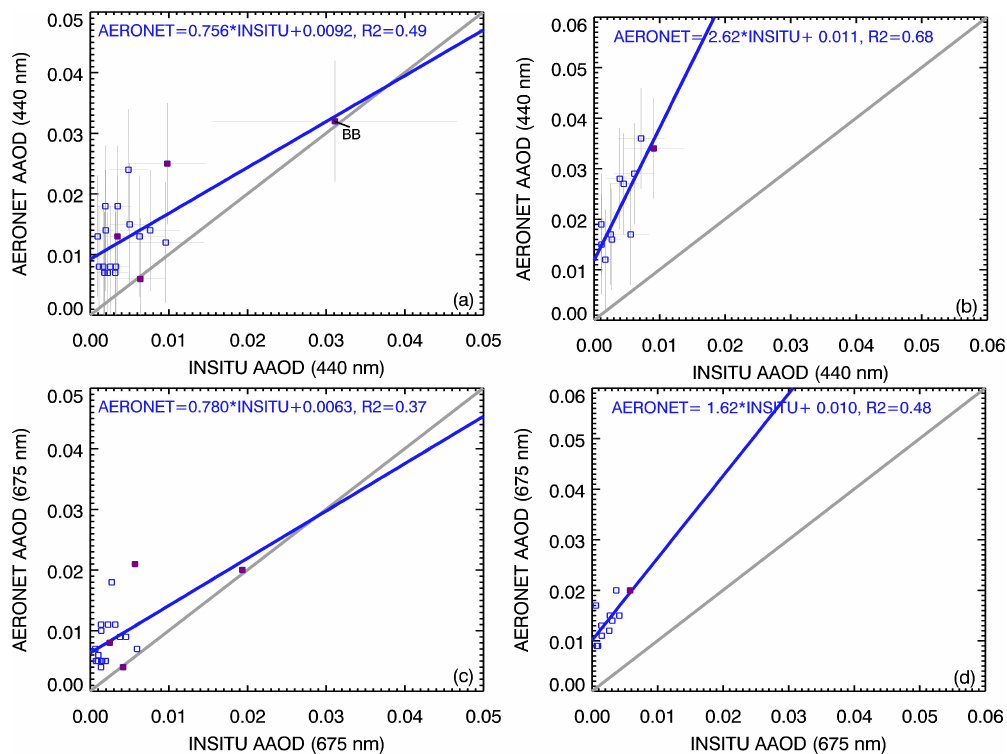
Figure 5. AAOD comparison: (a) BND at 440nm, (b) SGP at 440nm, (c) BND at 675nm and (d) SGP at 675nm. Blue line is linear fit for all points shown; gray line is 1-to-1 line. Thin gray lines associated with each data point represent measurement uncertainties. Points show the average of AERONET Level 1.5 AAOD retrievals for which there was a successful AERONET Level 2 almucantar retrieval within ± 3h of end of profile. Purple points indicate the few comparisons points for which there are AERONET Level 2 almucantar retrievals and where the average AERONET AOD 440 for those retrievals was great than